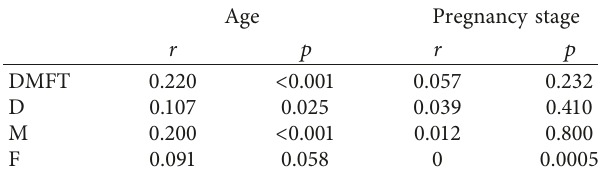
Table 2: Correlation of DMFTscores with age and pregnancy stage.